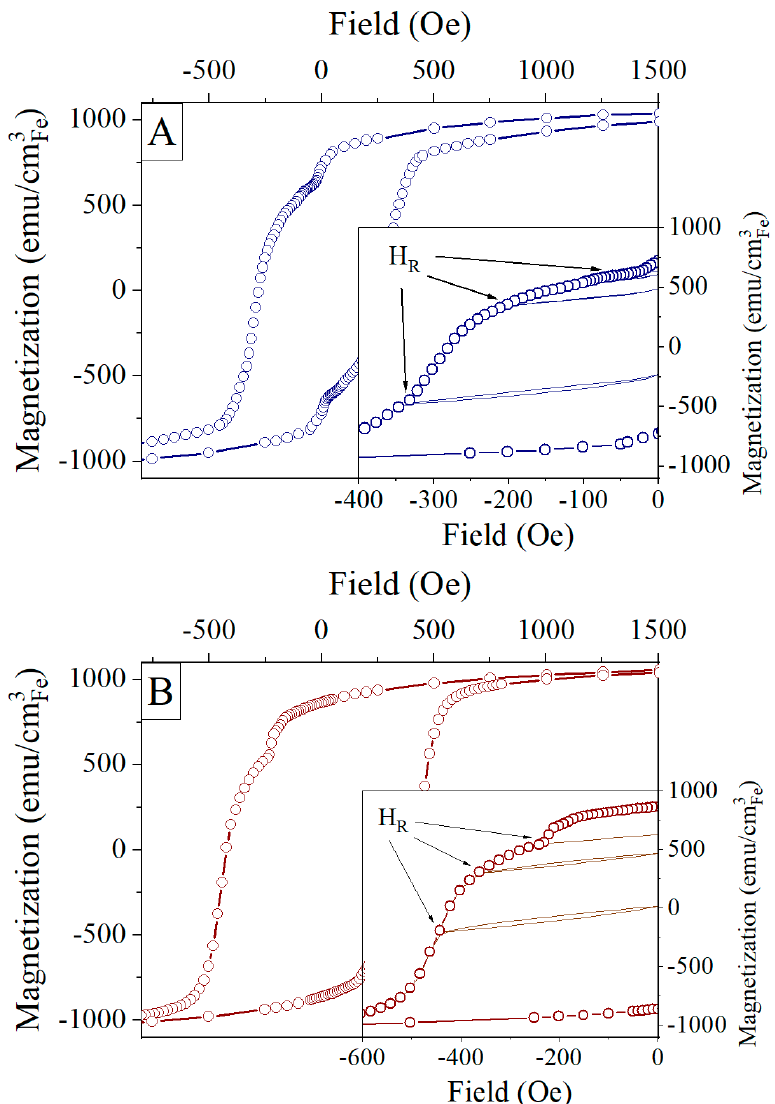
Figure 7. The hysteresis curves for sample S20 as-prepared ( A ) and annealed ( B ). The recoil curves (continuous lines) are shown in the insets. Magnetization and recoil curves were measured in the in-plane geometry.